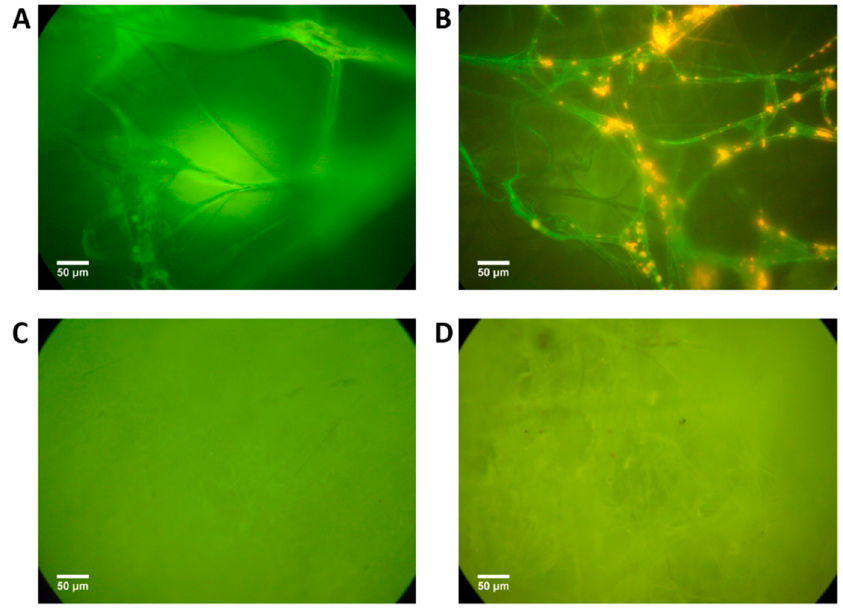
Figure 2. Fluorescence microscopy images of reference PP and s-PBC@PP coupon before ( A , C , respectively) and after ( B , D , respectively) 20 days of incubation with Pseudomonas aeruginosa in water.